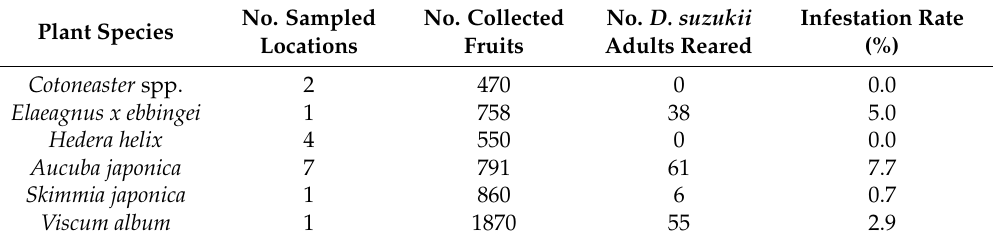
Table 2. Number (No.) of D. suzukii adults emerged from early host plants collected between March and June 2016 in the study area